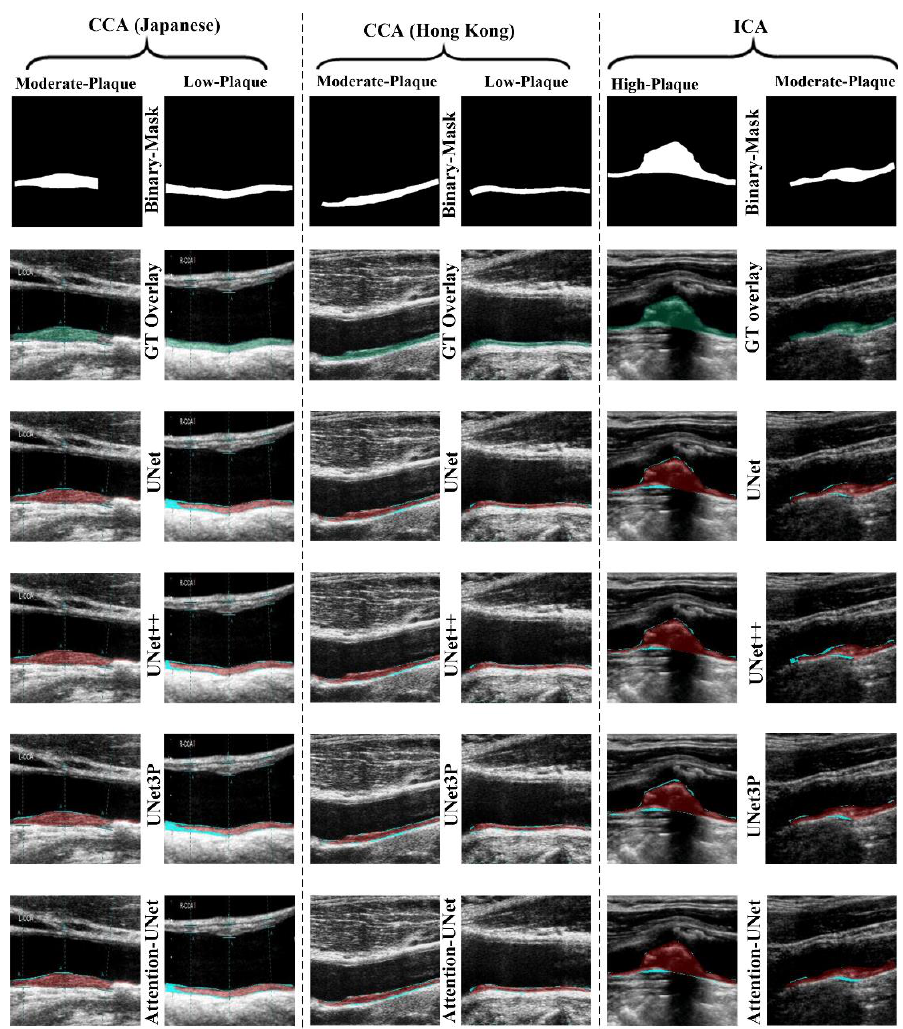
Figure 11. Visualizations of the Japanese, Hong Kong, and United Kingdom (ICA) databases were segmented using UNet, UNet++, UNet3P, and Attention-UNet models [96].